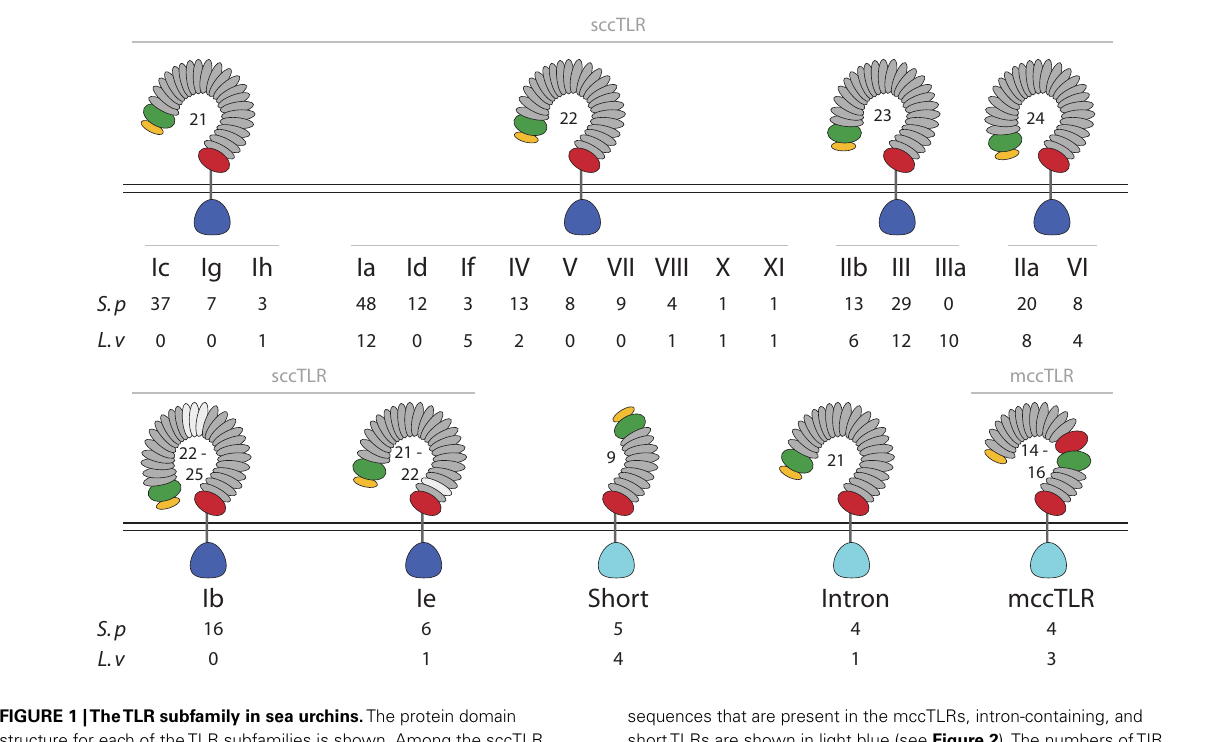
sequences that are present in the mccTLRs, intron-containing, and shortTLRs are shown in light blue (see Figure 2 ).The numbers ofTIR domains from each group and subfamily that are present in the S. purpuratus and L. variegatus genomes are shown below the diagram structures.